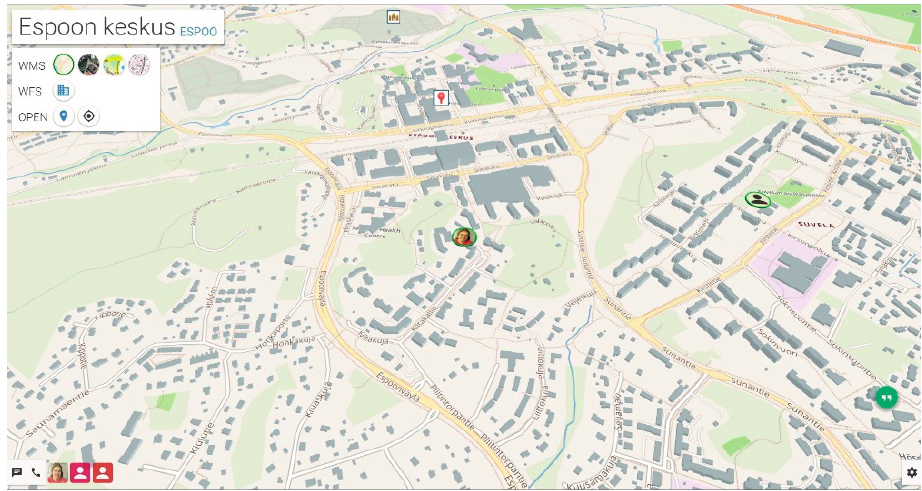
Figure 11. A Meshmoon Geo